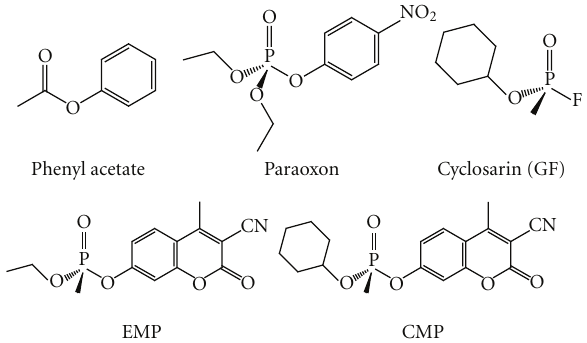
Figure 6: Structures of the substrates used in this study. CMP, EMP, and GF are shown as the S P